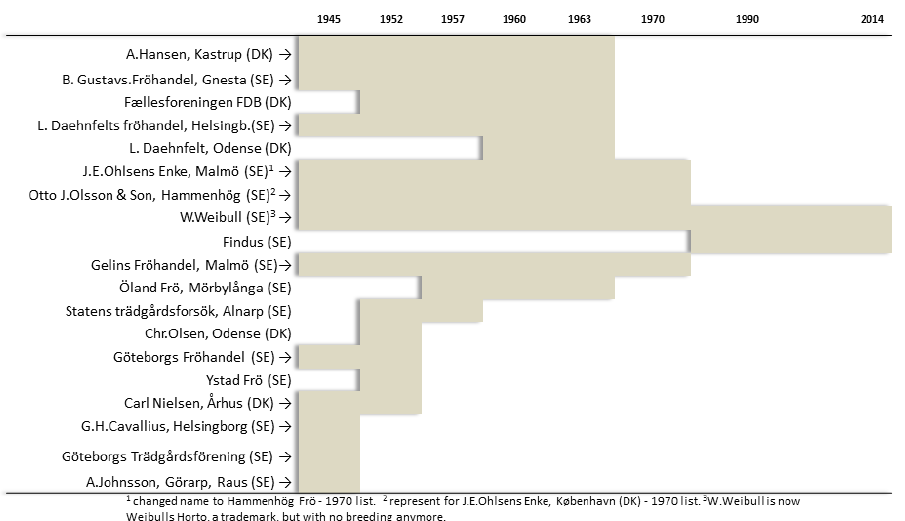
Fig. 4. Swedish and Danish seed enterprises with vegetable cultivars in the official variety trials/official variety list in Sweden from 1945 to 2014 (Lamm et al. 1945, 1952, 1957, 1960, 1963, Official Swedish List of Cultivars 1970, 1990,